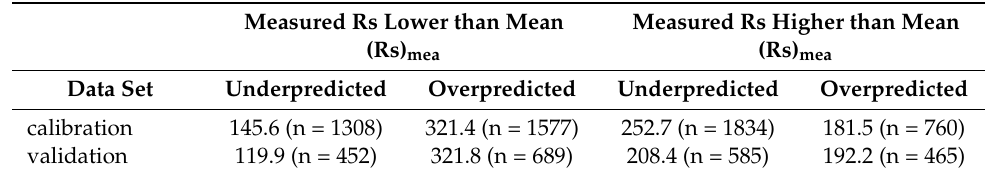
Figure 11. Solar radiation estimated by proposed model at Puno station versus measured values in calibration and validation sets. Table 16. RMSE values (J · cm − 2 · day − 1 ) and number of data points belonging to under- and over- estimation sets for measured solar radiation less or higher than mean (Rs) mea in calibration and validation phases using proposed model.